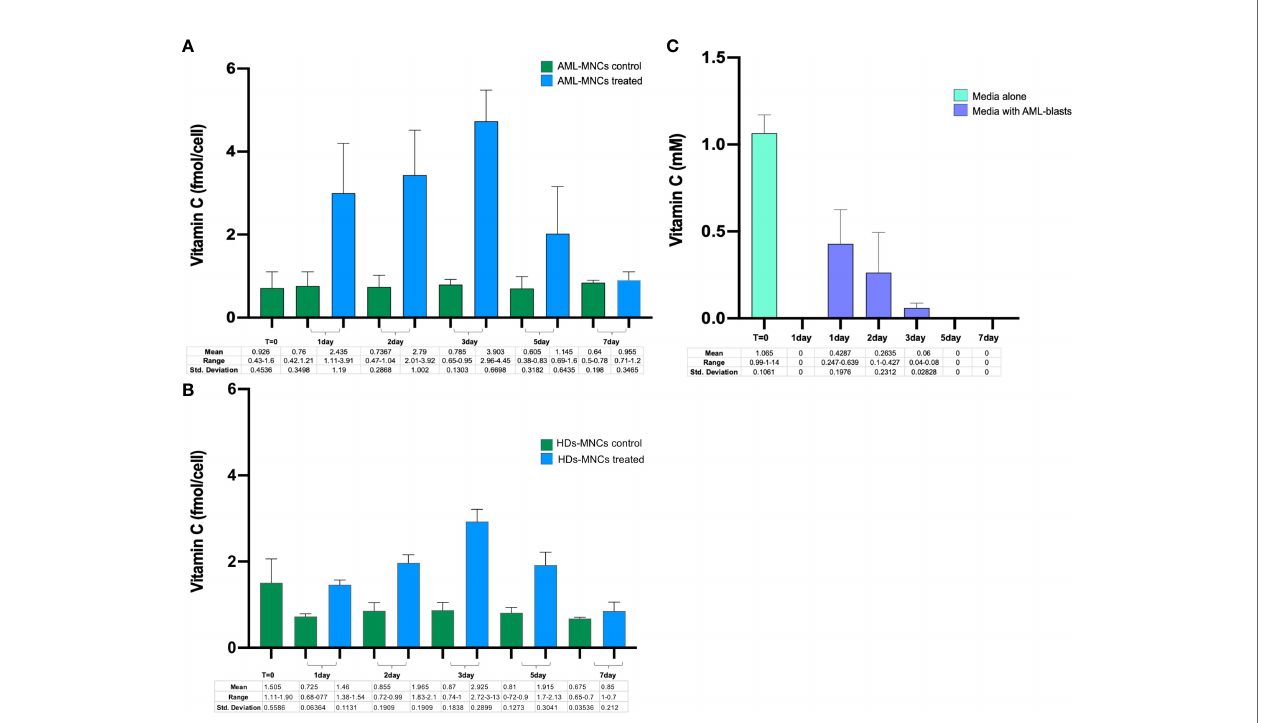
FIGURE 6 | PB-MNCs were puri fi ed from AML samples at diagnosis and from healthy donors. In particular, 10 6 primary cells/ml were cultured for one week with or without 1mM ascorbate and analyzed for vitamin C uptake at different time points. (A) Vitamin C uptake in untreated MNCs (green bar) and after incubation with 1mM ascorbate (blu bar) in AML (N=5) and (B) in HDs (N=2). (C) Concentration of vitamin C in culture medium with or without AML-MNCs. The light green bar (T=0) shows the level of vitamin C just after addiction of 1mM of ascorbate in the free cell culture medium. After one day in the incubator, vitamin C is anymore detectable. The purple bars show the vitamin C detected in culture medium after 1-7 days in presence of ascorbate treated MNCs. Data represent means of 5 in vitro